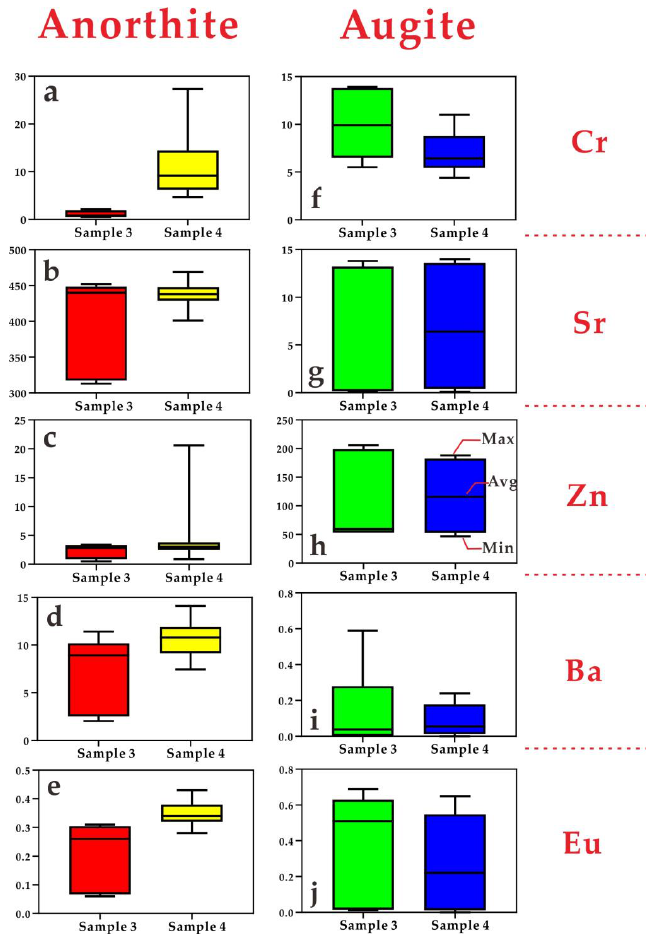
Figure 5. Comparison of the specific trace element variations in anorthite ( a - e ) and augite ( f - j ).